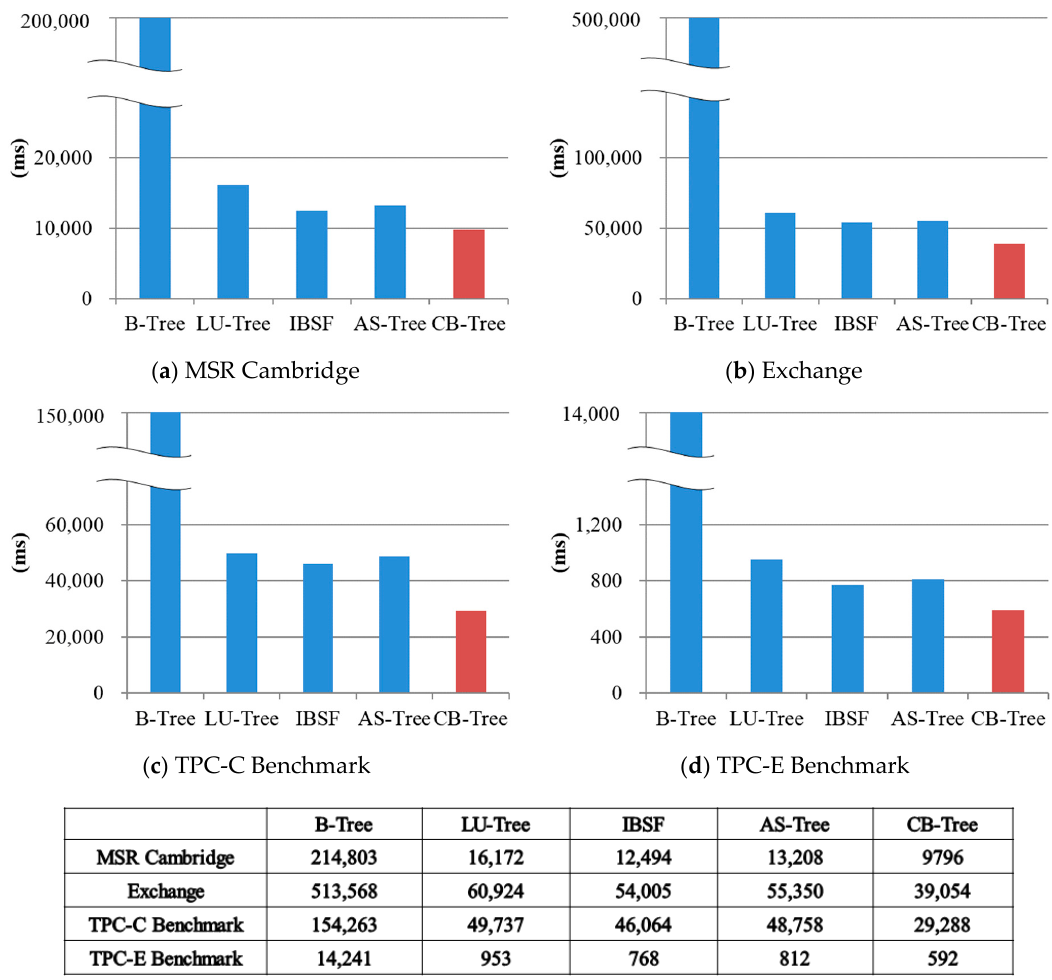
Figure 13. Creation time in buffer-based B-trees (total elapsed time).